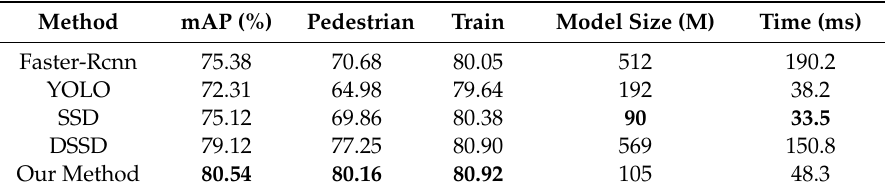
Table 8. Results comparison of different methods on the railway dataset.